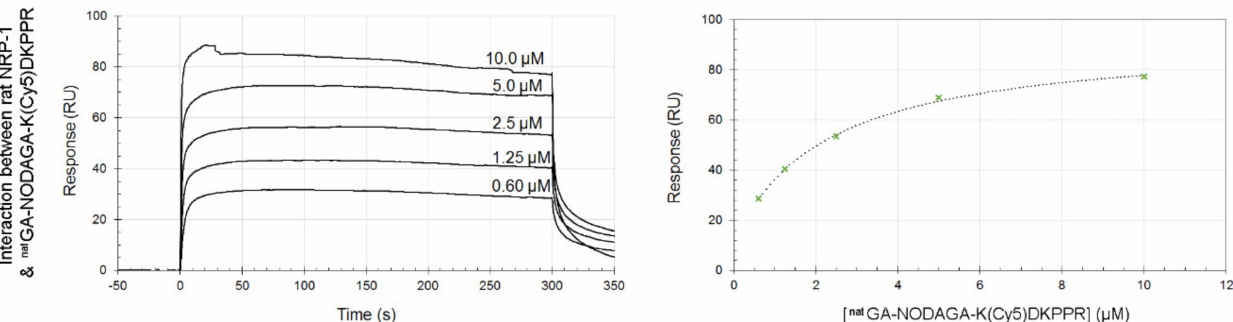
Figure 6. SPR experiments. Sensorgrams ( left ) and titration ( right ) curves corresponding to the interactions between rat-NRP-1 and nat Ga-NODAGA-K(Cy5)DKPPR. Briefly, IgG1 and recombinant rat NRP-1 were immobilized on a CM5 sensor chip. nat Ga-NODAGA-K(Cy5)DKPPR (0.60–10 µ M) was injected at a flow rate of 30 µ L.min − 1 at a temperature of 25 ◦ C. Data were recorded and presented as the response (RU) as a function of time (s) after double-referencing: